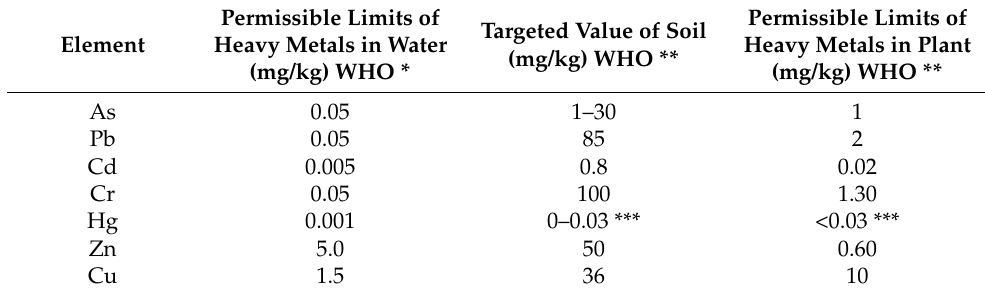
Table A2. Permissible limits and targeted concentration of heavy